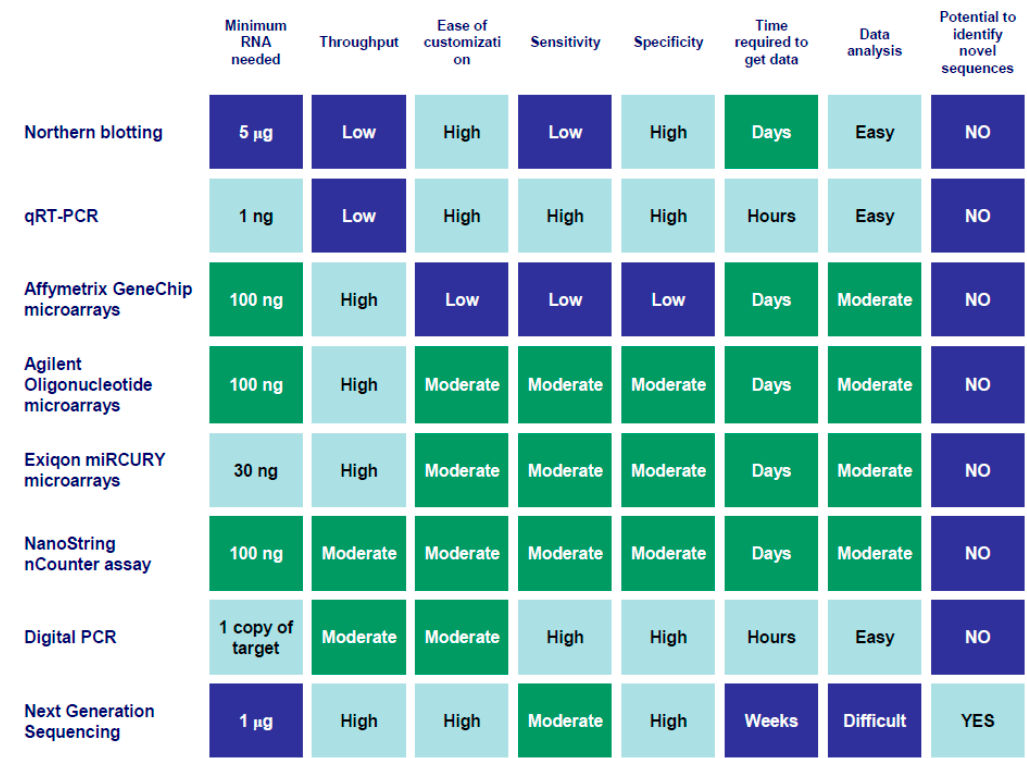
Figure 4. Comparison of methods commonly used to study extracellular RNA. Color code indicates the relative feasibility of that particular technique based on a given feature, from light blue (more feasible), through turquoise, to dark blue (less feasible). Data analysis: Easy (feasible in any molecular biology lab), Moderate (various software platforms available), Difficult (requires advanced computational infrastructure).